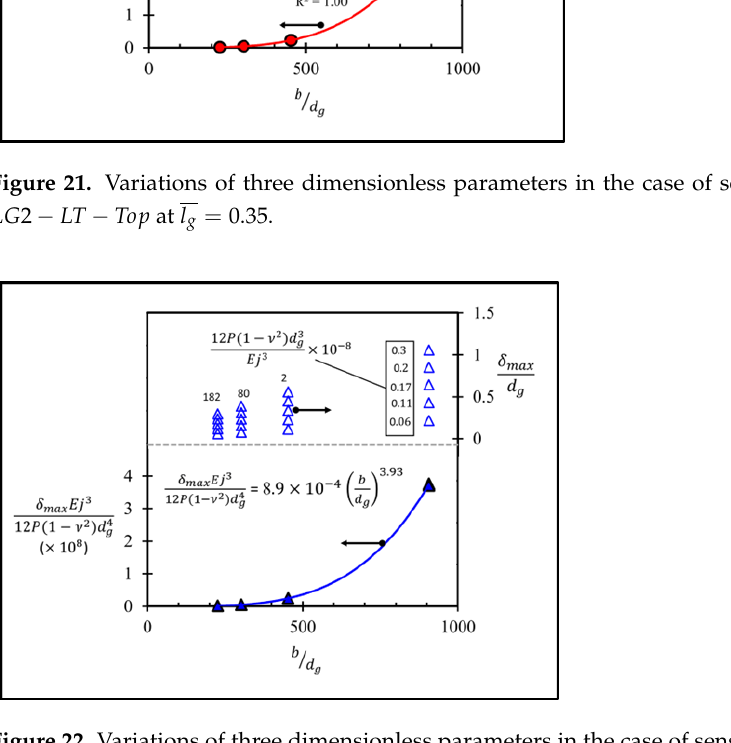
Figure 22. Variations of three dimensionless parameters in the case of sensor with annular groove AG − Top .